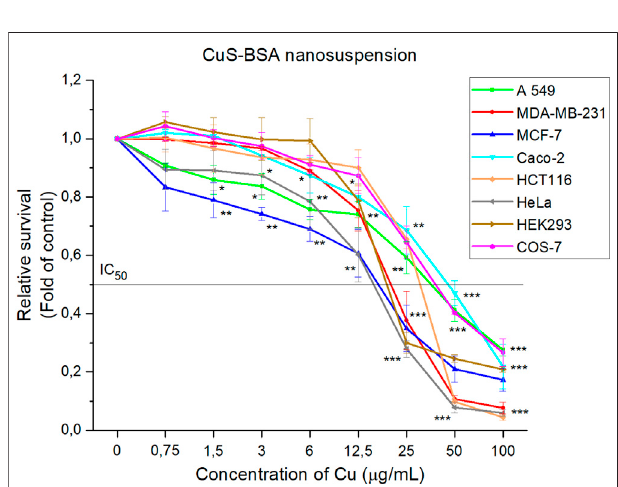
FIGURE 12 | Relative cell lines survival after treatment with BSA solutions. The data are presented from three independent experiments.